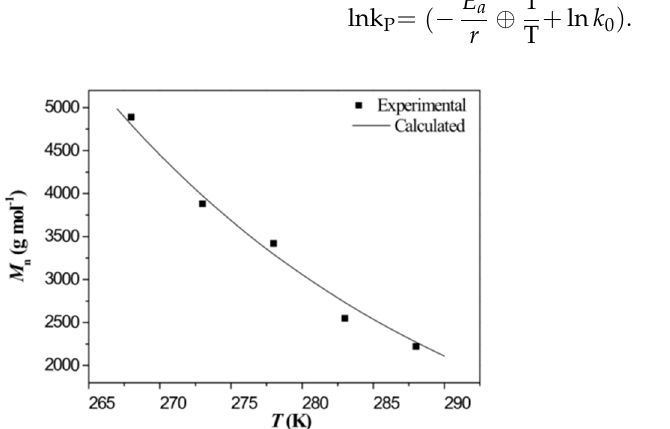
Figure 3. Effect of T on the M n of PIB when Q M = 33.7 L · h − 1 , Q I = 6.24 L · h − 1 , [M] t = 2.00 mol · L − 1 , [I] t = 0.22 mol · L − 1 and N = 1600 rpm.